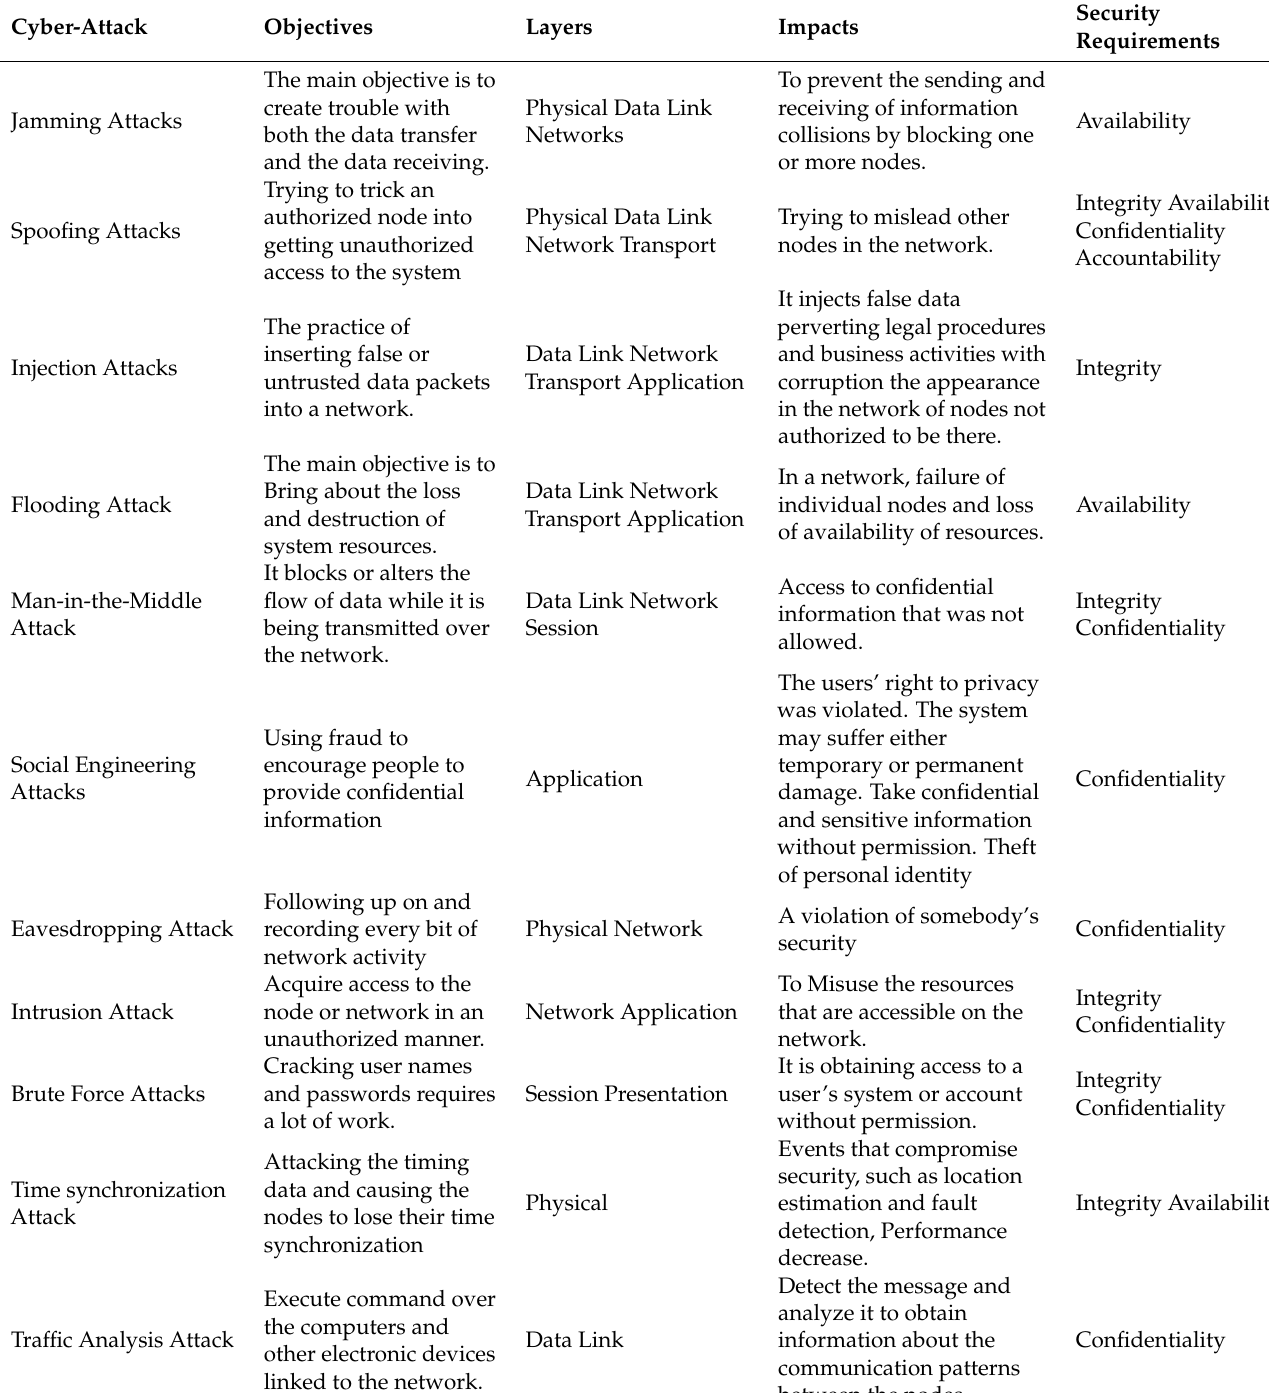
Table 4. Cyber-Attacks in Smart grids